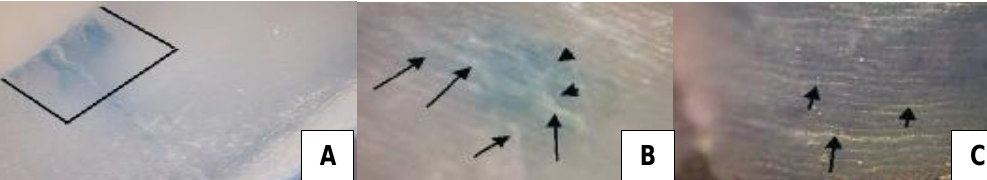
Figure 3: Group B.. A. A.. Rectangle demarked area of deminerlized lesion of blue stains .X 4, B.. Magnifying view for previous figure A shows localized (blue) unminerlized lesion (arrow head), over layed with sparses thin hybrid-like ufine layer of infiltrated applied material (arrows).X10 C.. Longitudinal ground section for enamel tooth pretreatment with RMGIC shows dark deminerlized lines interdigited with reminerlized layers of translucent shiny lines (arrows) .X4